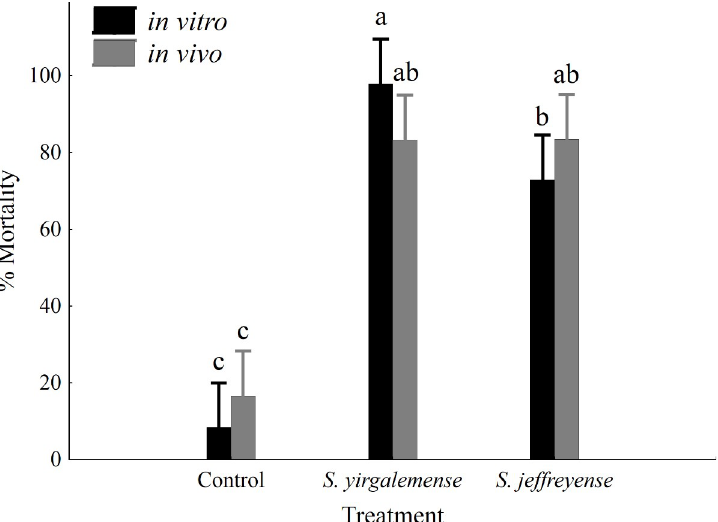
Fig 1. Percentage mortality of Lobesia vanillana larvae, 48 h after treatment. Percentage insect mortality (95% confidence intervals) of Lobesia vanillana larvae, 48 h after inoculation with in vitro- and in vivo -cultured infective juveniles of Steinernema yirgalemense and S . jeffreyense , at a concentration of 100 IJs/50 μ l. Vertical bars were calculated using least square means. Different letters on the bars denote statistical significance, calculated using Fisher’s LSD (MSE = 267.64; df = 42; p <